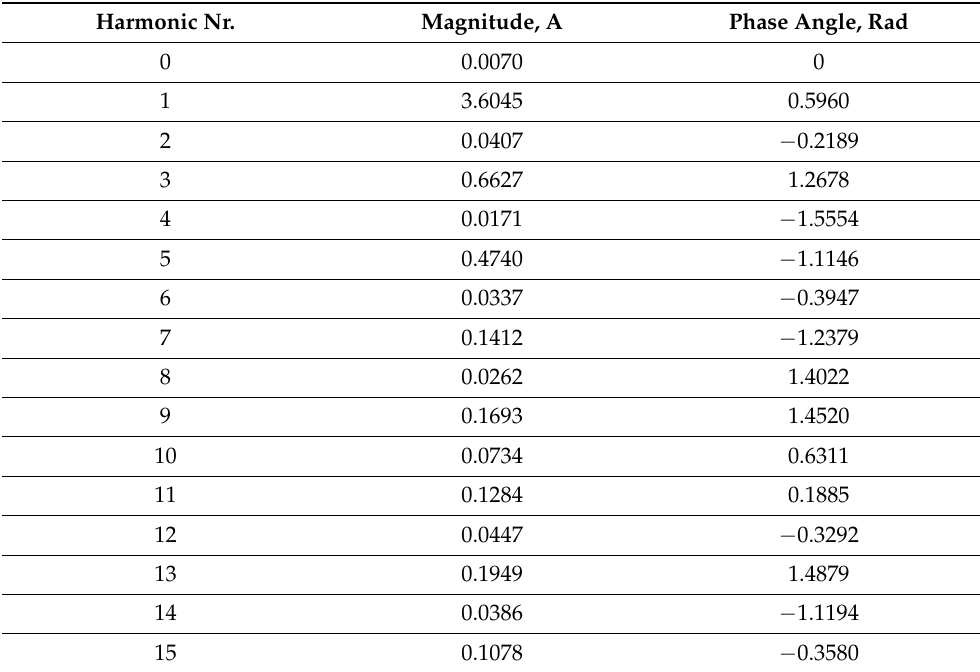
Table 4. Values of the harmonics for accurate reproduction of the input current of the LED wall display. Harmonic